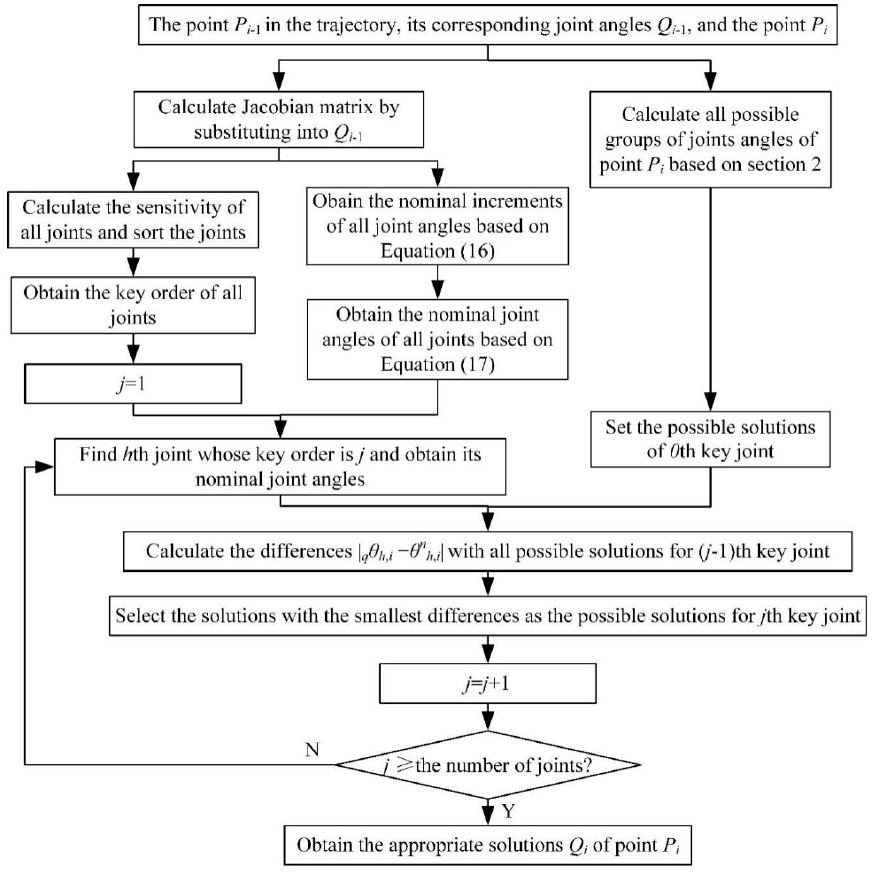
Figure 4. The flow chart of the multisolution selection method based on the key order of joints.